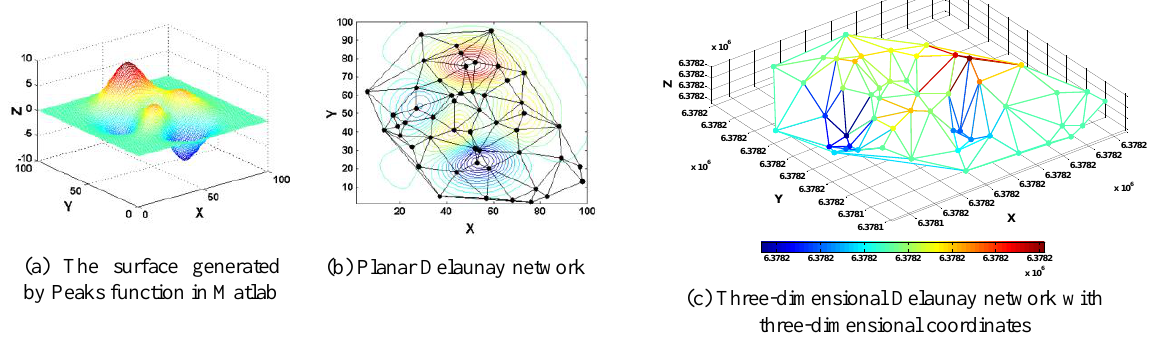
Figure 3. The Delaunay networks generated respectively by planet coordinates and three-dimensional coordinates 4.